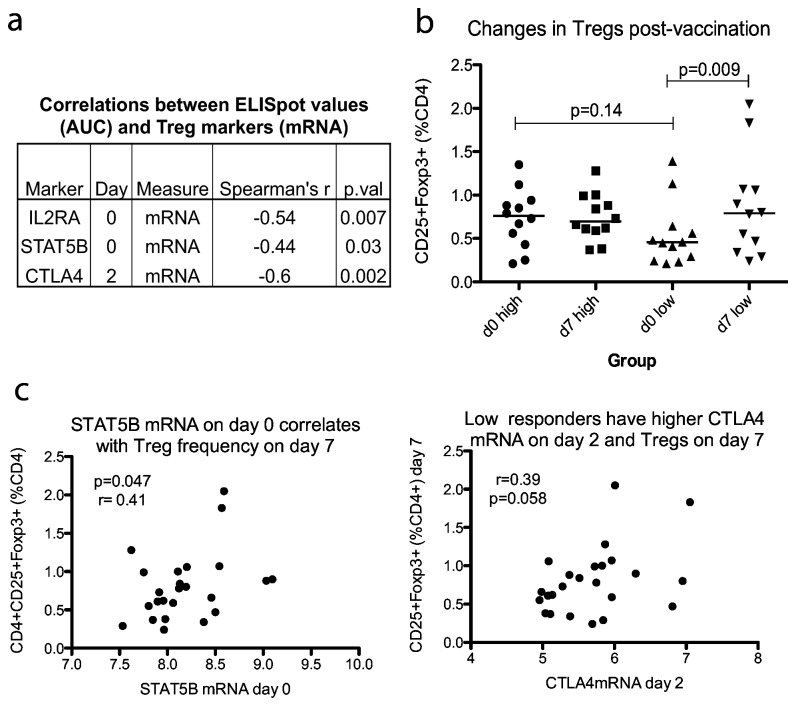
Low responders make a stronger regulatory response to vaccination with MVA85A.To further explore the relationship between Treg marlers and IFN-γ ELISpot response identified through the microarray, flow cytometry of Treg markers was done of cells from the same volunteers taken on day of vaccination (day 0) and 1 week later (day 7). - A. mRNA levels as measured by microarray for several Treg markers show an inverse correlation with the IFN-γ ELISpot response. B. The Treg population (CD4+ CD25+ Foxp3+) is increased in low but not high responders during the first week following vaccination (paired t-test, p=0.009) C. STAT5B expression on day 0 correlates with frequency of Tregs (CD25+ Foxp3+, % CD4+) and there is a trend between expression of CTLA4 on day 2 and Tregs on day 7. Treg absolute counts: mean: 1687, median: 1631, interquartile range: 740-2882.